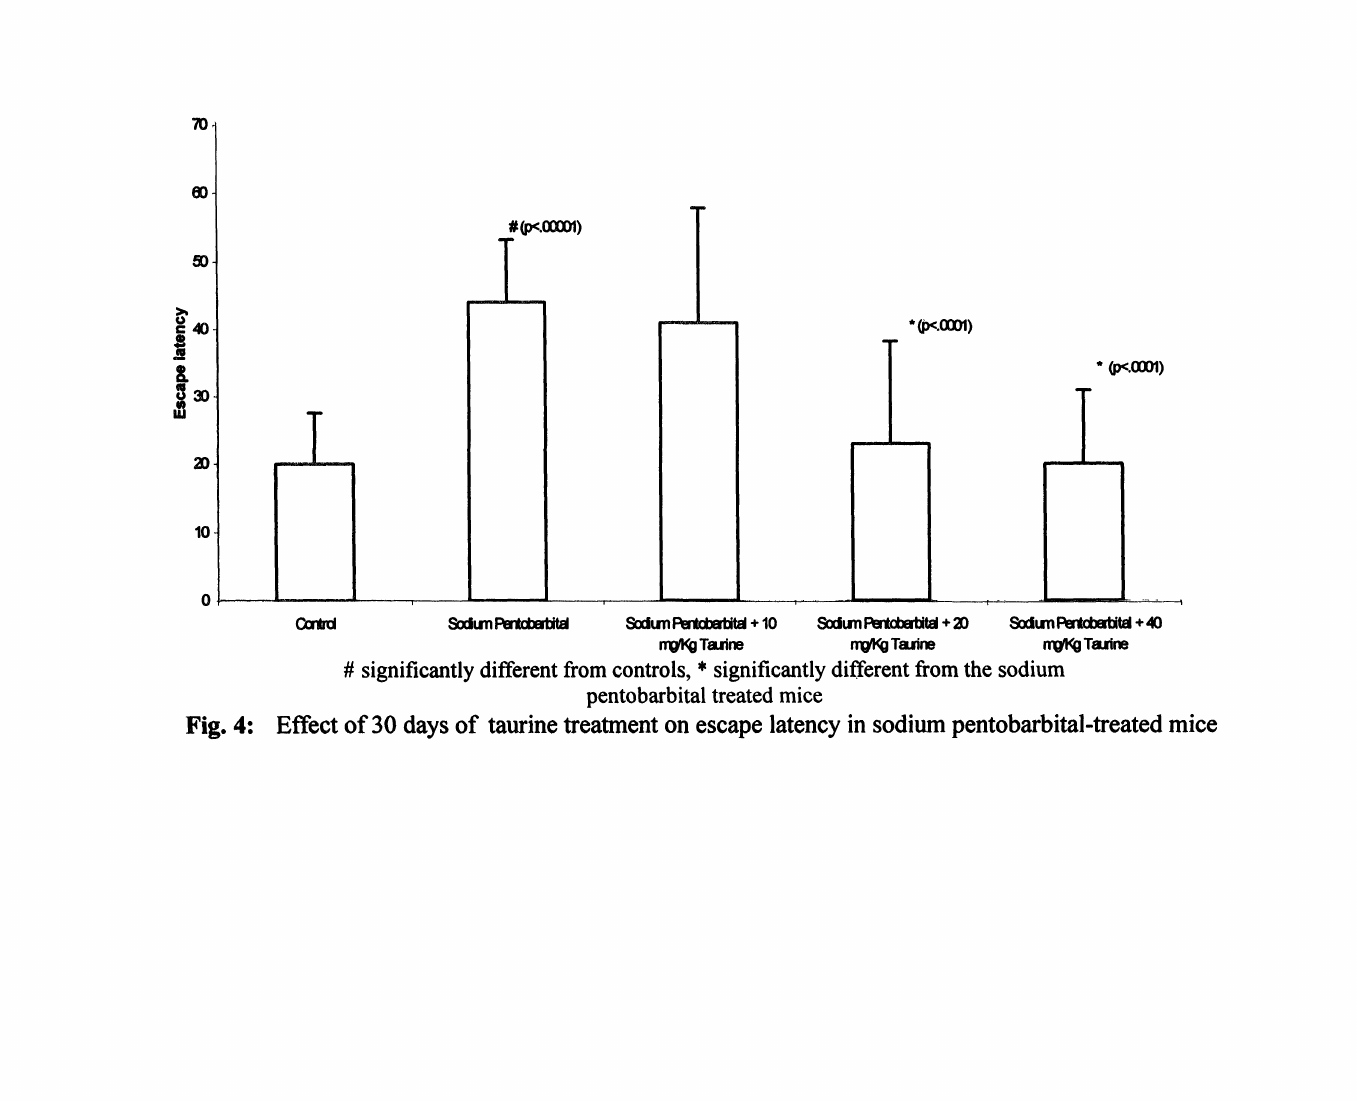
Scxfu’nPenlol:at +10 O:rt’d S=:kmPer +20 Soau’nPer +40 rrg Ta,ltle # significantly different from controls, * significantly different from the sodium pentobarbital treated mice Fig. 3: